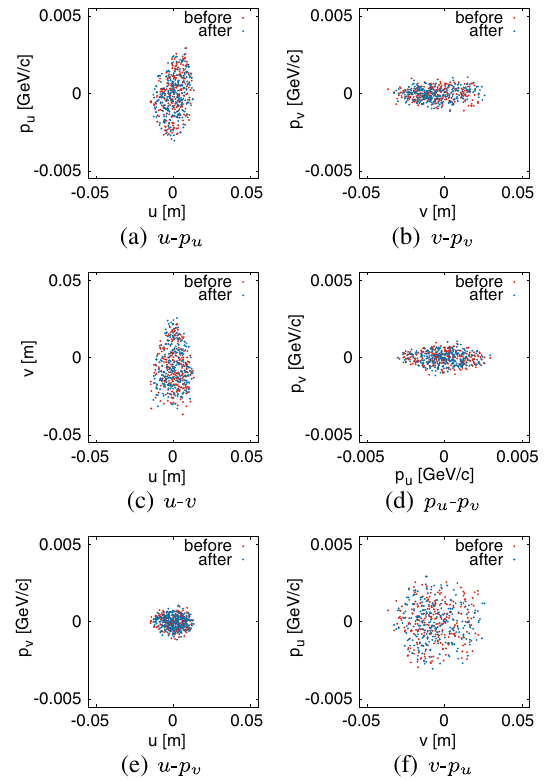
FIG. 10. Dynamic aperture defined by surviving particles in 4D space after 1000 turns, (a) u - p , (b) v - p , (c) u - v , (d) p - p , and (b) y - p u v u v x y (e) u - p , (f) v - p . Red dots show the initial coordinates and blue v u dots are the final coordinates. Projections onto the decoupled spaces ((a) u - p and (b) v - p ) show that normalised dynamic u v aperture is estimated to be about 30 π mm mrad. Projections of the 4D phase space volume onto other planes are also